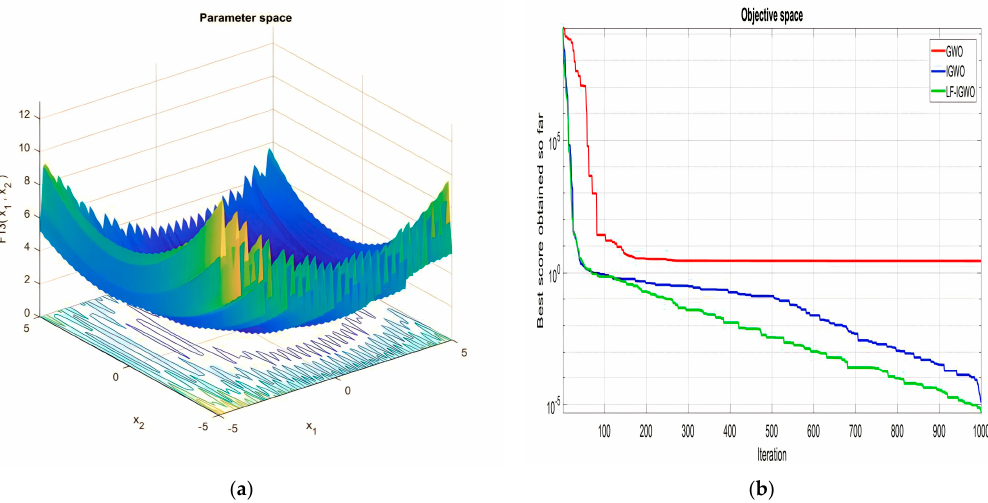
Figure 15. ( a ) Search space for multi model function F13 ( b ) Comparison of convergence curve for F13.